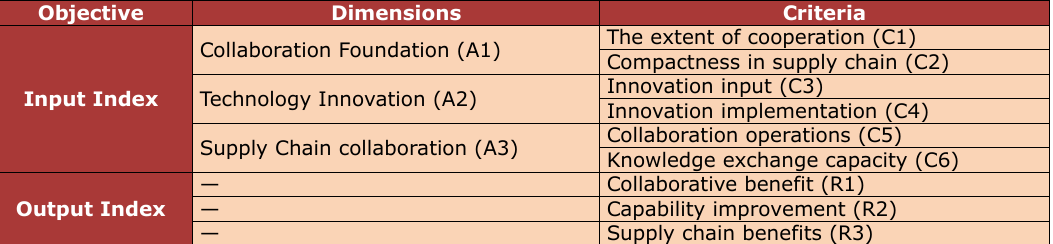
Table 1. Dimensions and criteria of the evaluating